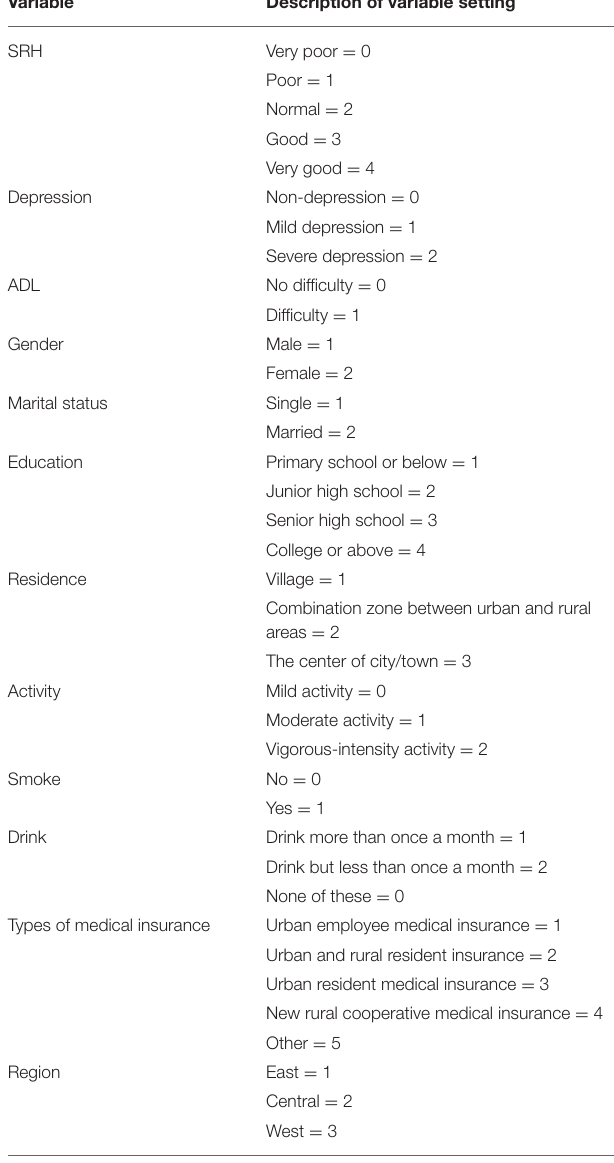
TABLE 1 | Variable